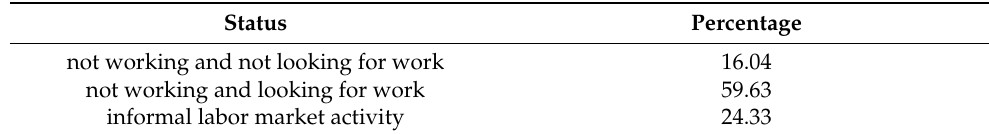
Table 6. Labor market status of youth out of school, not enrolled in tertiary education, and not active in the formal labor market.